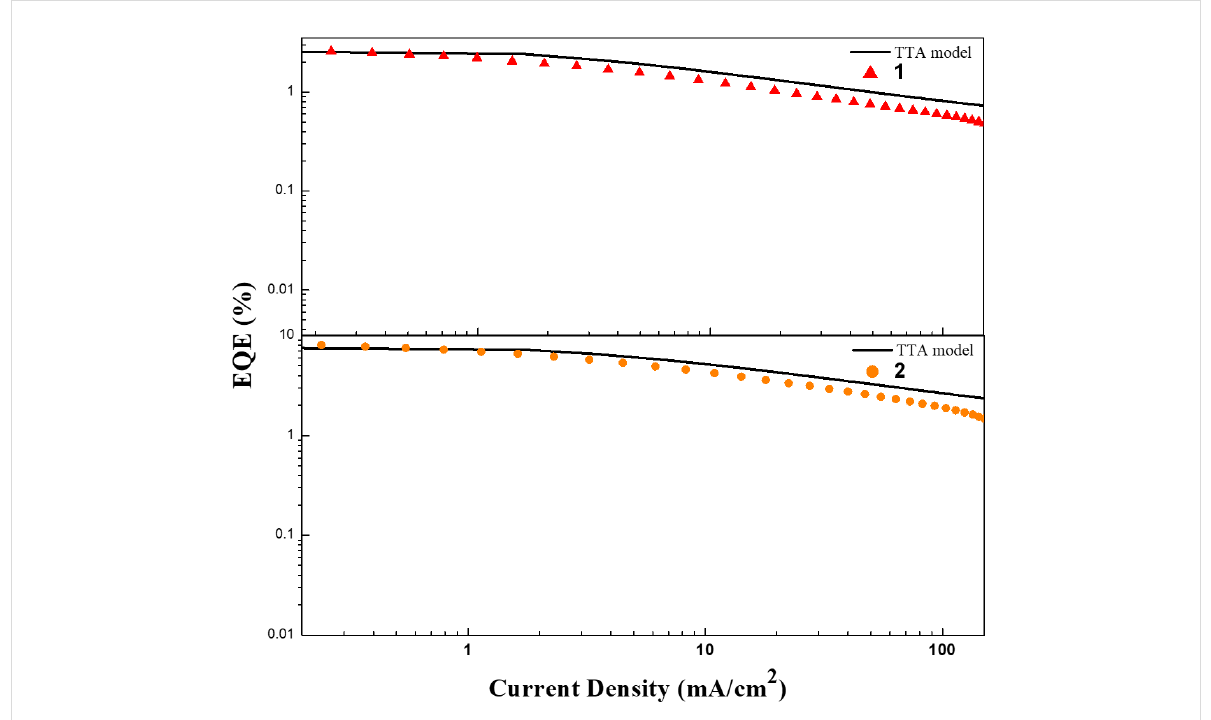
Figure 7: EQE–current density characteristics of the devices based on 1 (top) and 2 (bottom). The solid lines represent the simulated EQE by em- ploying the TTA model.